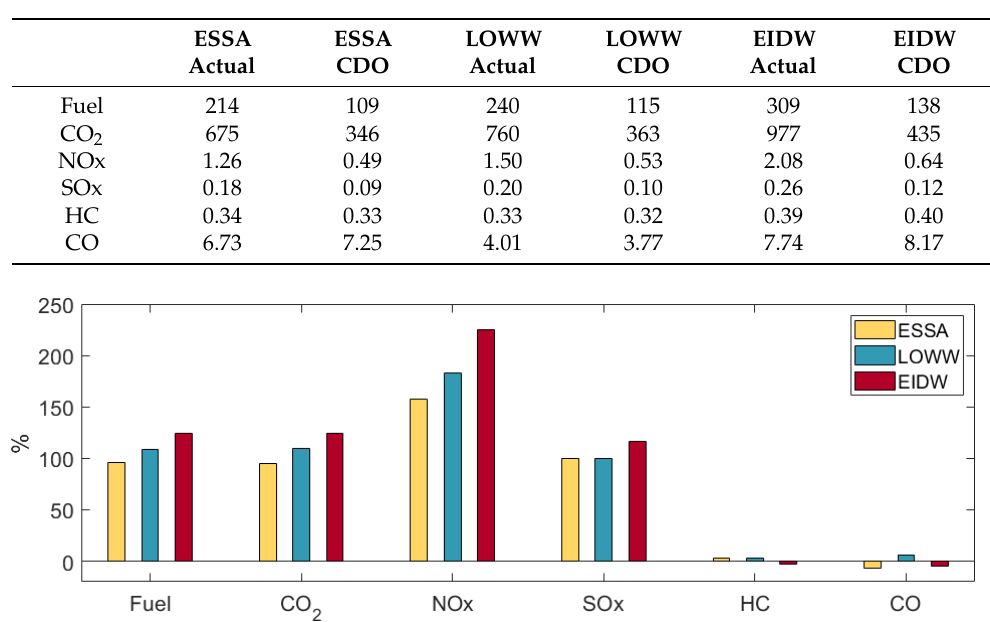
Figure 8. Additional fuel burn and emissions, in TMA, for the actual trajectories compared to